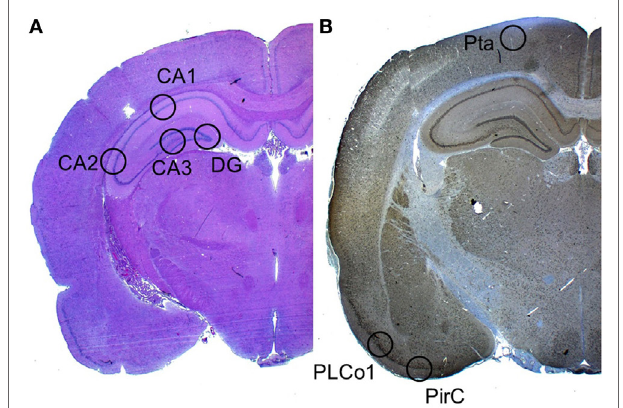
Figure 2 | Selected regions of interest. (a) In H&E staining, a high power field was focused on four regions of interest: CA1, CA2, CA3, and DG. (B) In Iba-1 staining (the image displays a NeuN staining), a high power field was focused on the three cortical regions of interest: Pta, PLCo1, and